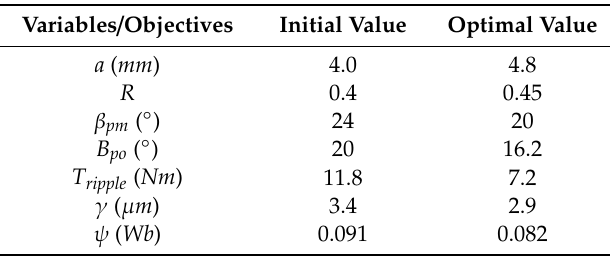
Figure 9. The optimization results of the three optimization objectives in step 2. Table 4. Optimal design in step